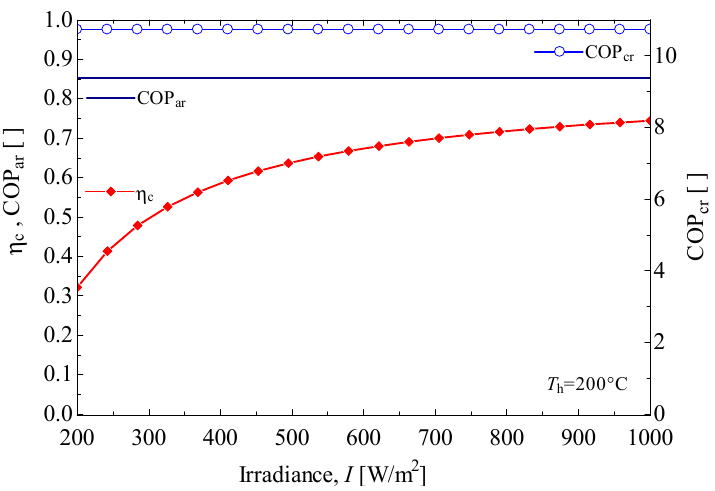
Figure 10. Efficiency of the solar collector and cooling systems, with respect to radiation in the solar concentrator.